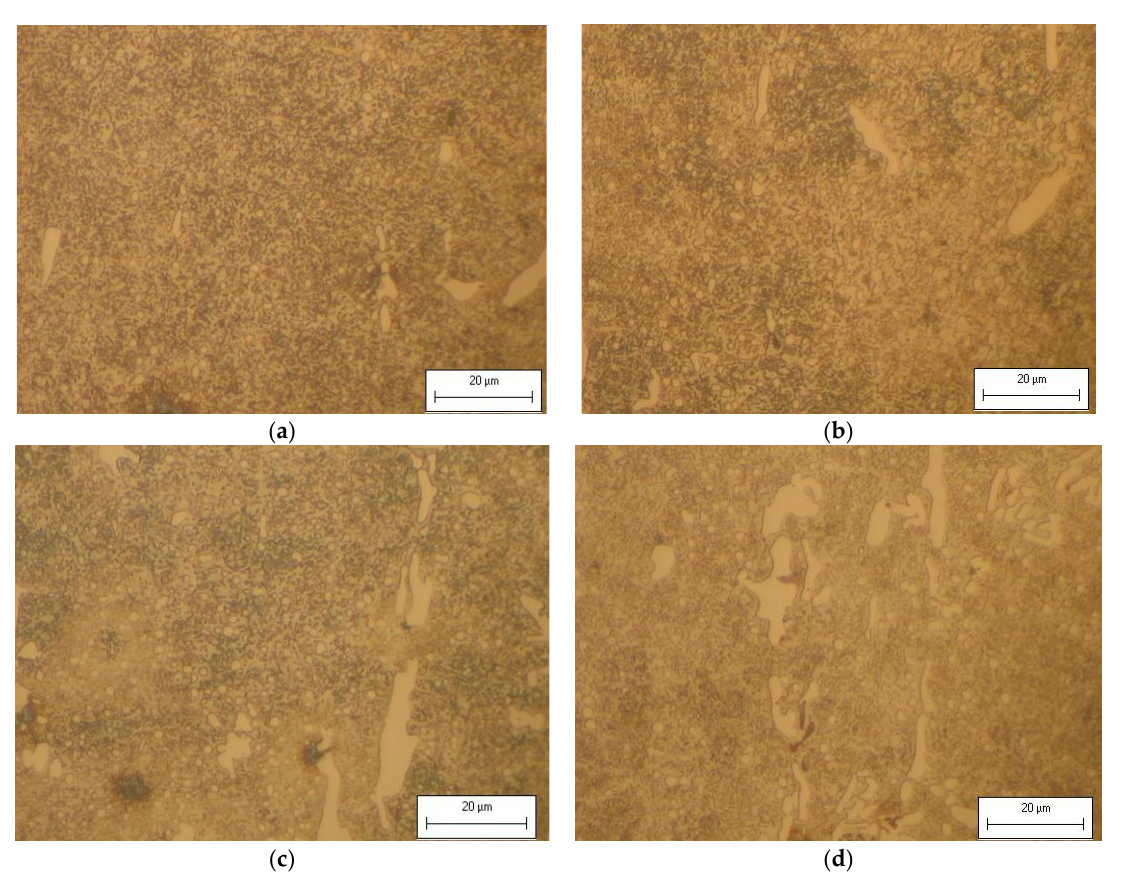
Figure 4. Microstructure of Material Samples at Different Temperatures: ( a ) Room Temperature,